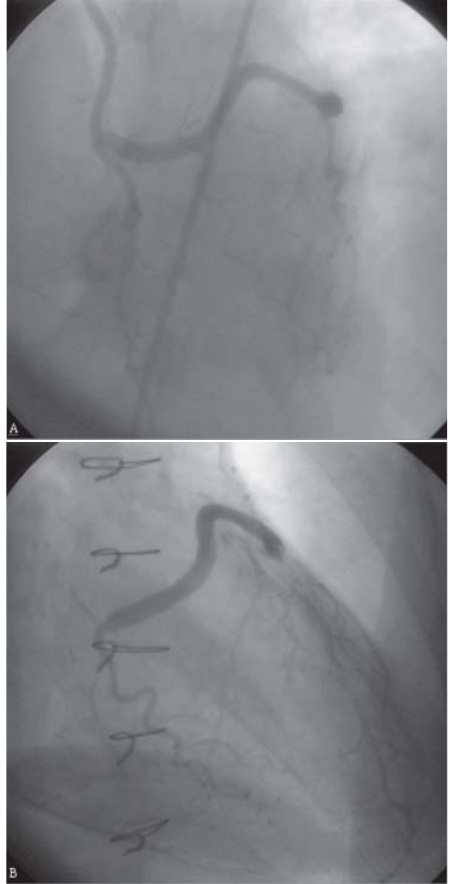
Fig. 2 – A: Projeção oblíqua anterior esquerda. B: projeção oblíqua anterior direita